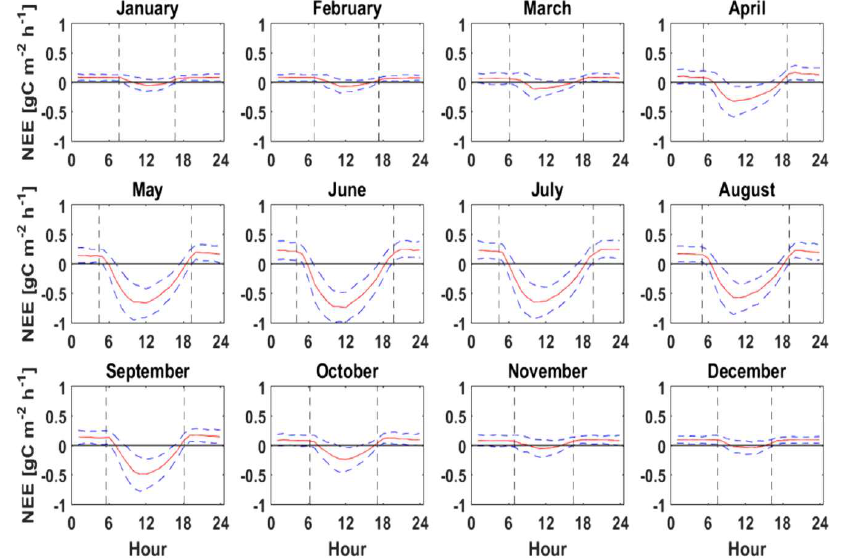
Figure 4. Mean diurnal variation of NEE by months during the years 2008 to 2017; blue dashed lines represent standard deviation among years; vertical dashed lines mark the time of sunrise and sunset on the 15 day in a month.